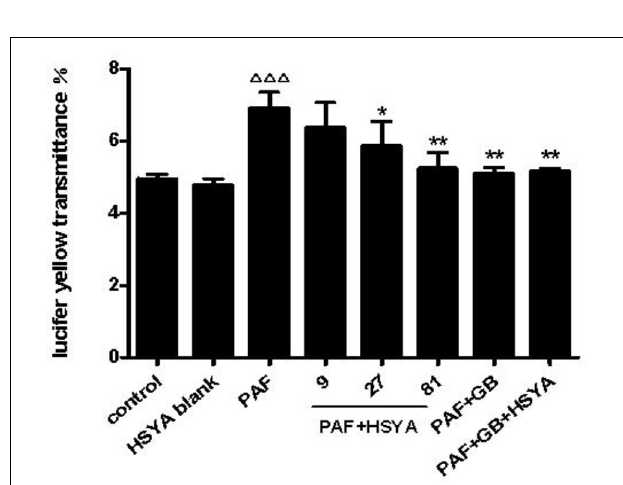
FIGURE 5 | Effect of HSYA on transmittance of Lucifer yellow (indicating paracellular permeability) in PAF-stimulated HSAECs. Data presented as mean ± SD, n = 3 per group. ANOVA, p < 0.0001, post hoc (cid:49)(cid:49)(cid:49) p < 0.001 versus control group, ∗ p < 0.05, ∗∗ p < 0.01 versus PAF